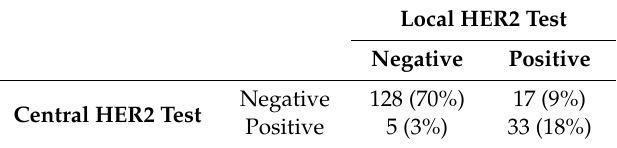
Table 2. HER2 concordance / discordance rate according to local / central